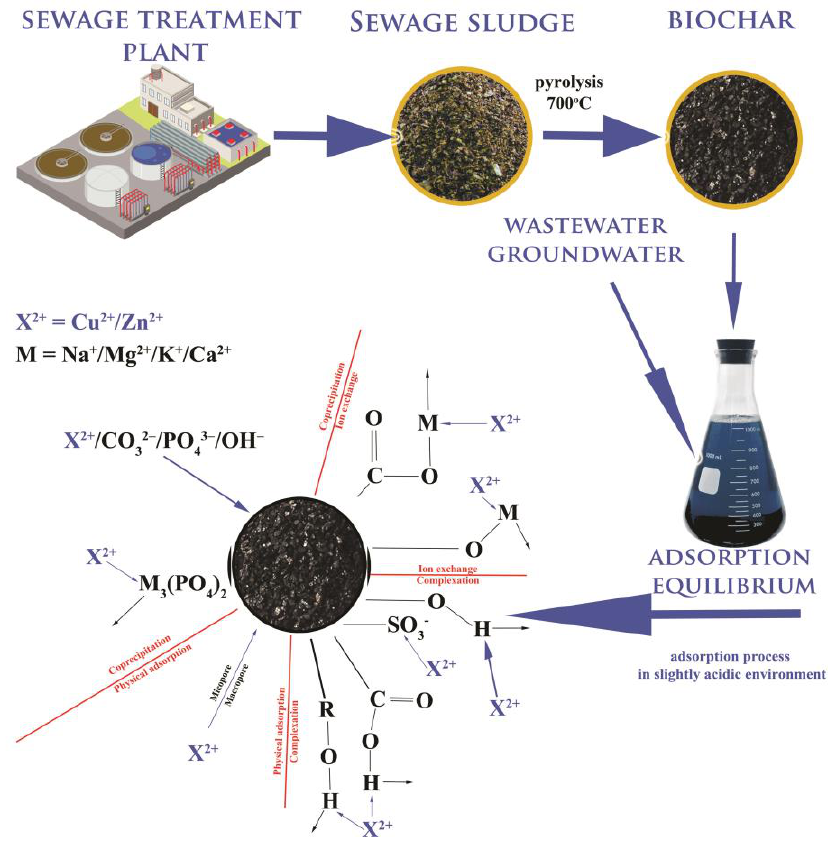
Figure 18. Proposed adsorbent/adsorbate interactions mechanism for obtained municipal sewage sludge biochar.